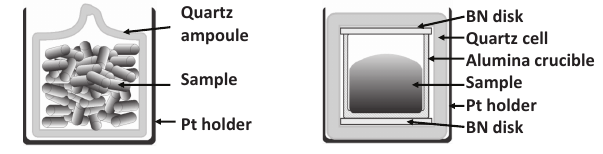
Figure 2. Schematic diagram of sample assembly.